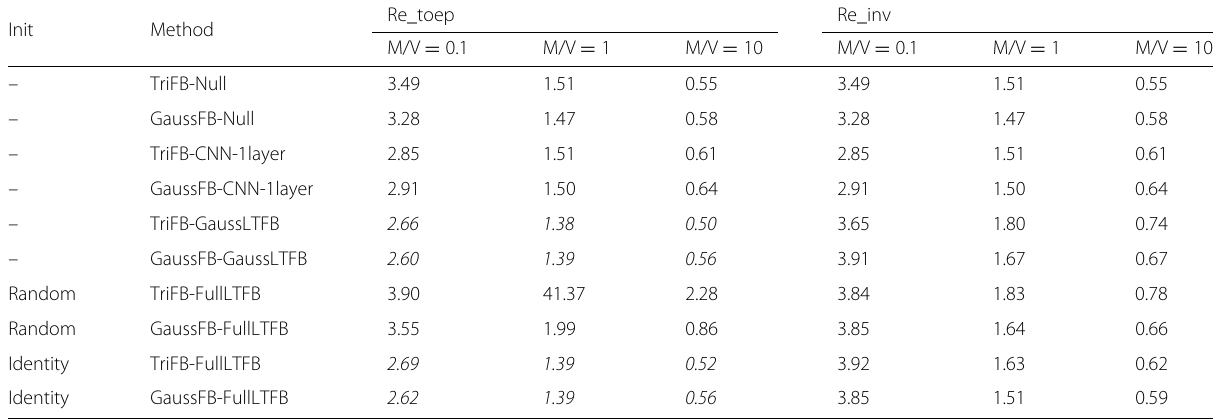
Table 1 Reconstruction error of audio source separation using frequency filter banks as input Init